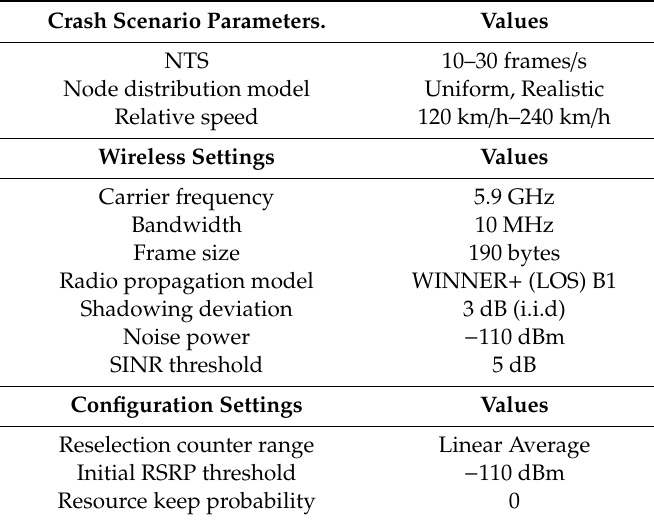
Table 2. Key parameters in simulations. Crash Scenario